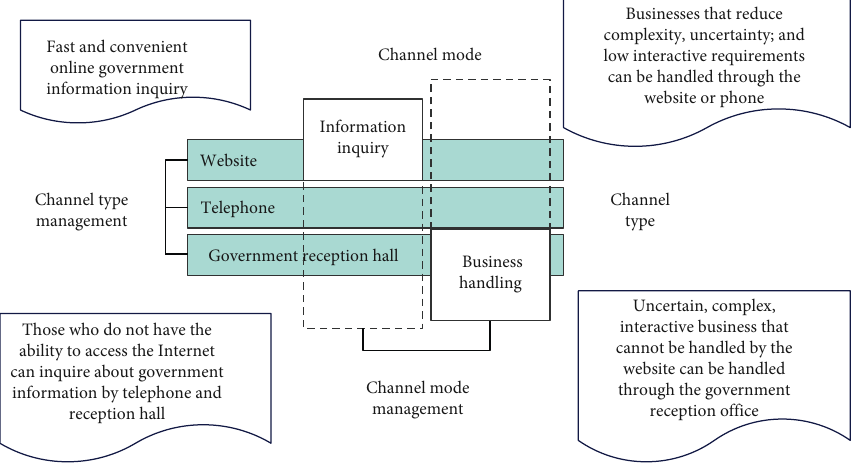
Figure 7: Public service channel management model based on service feature matching degree.